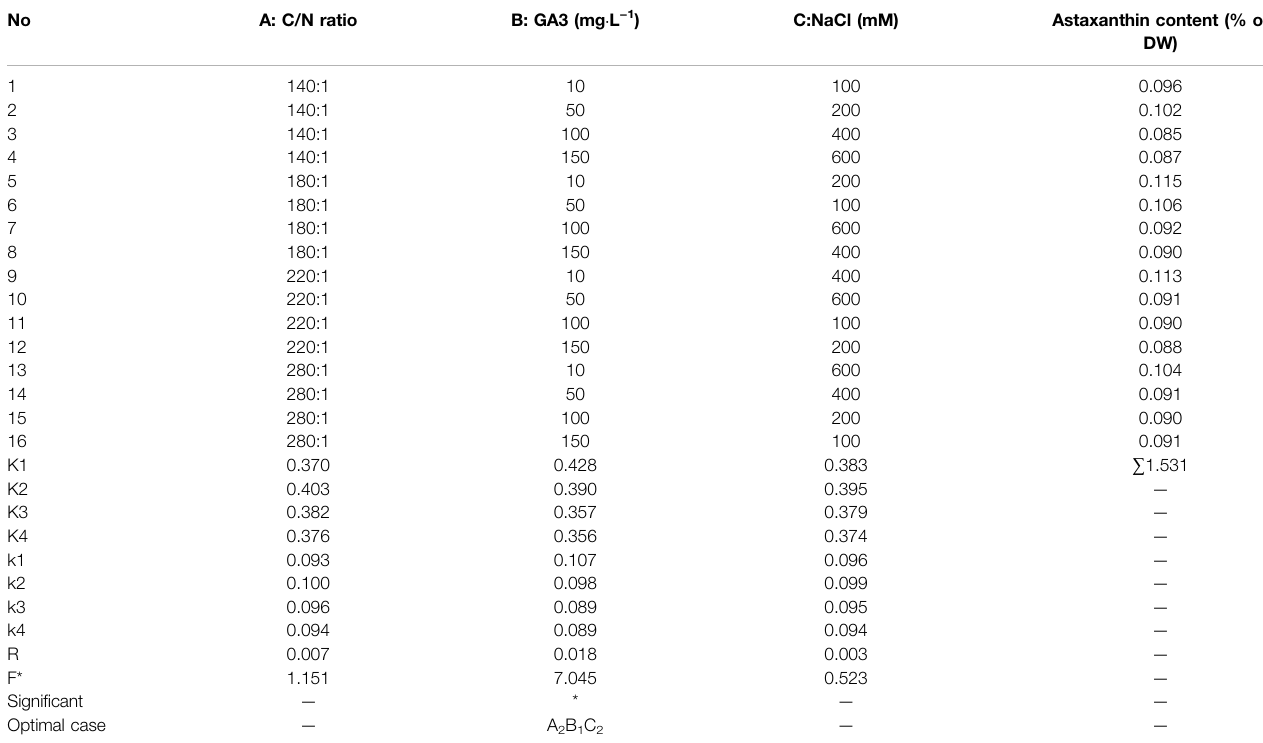
TABLE 2 | Orthogonal range analysis and variance